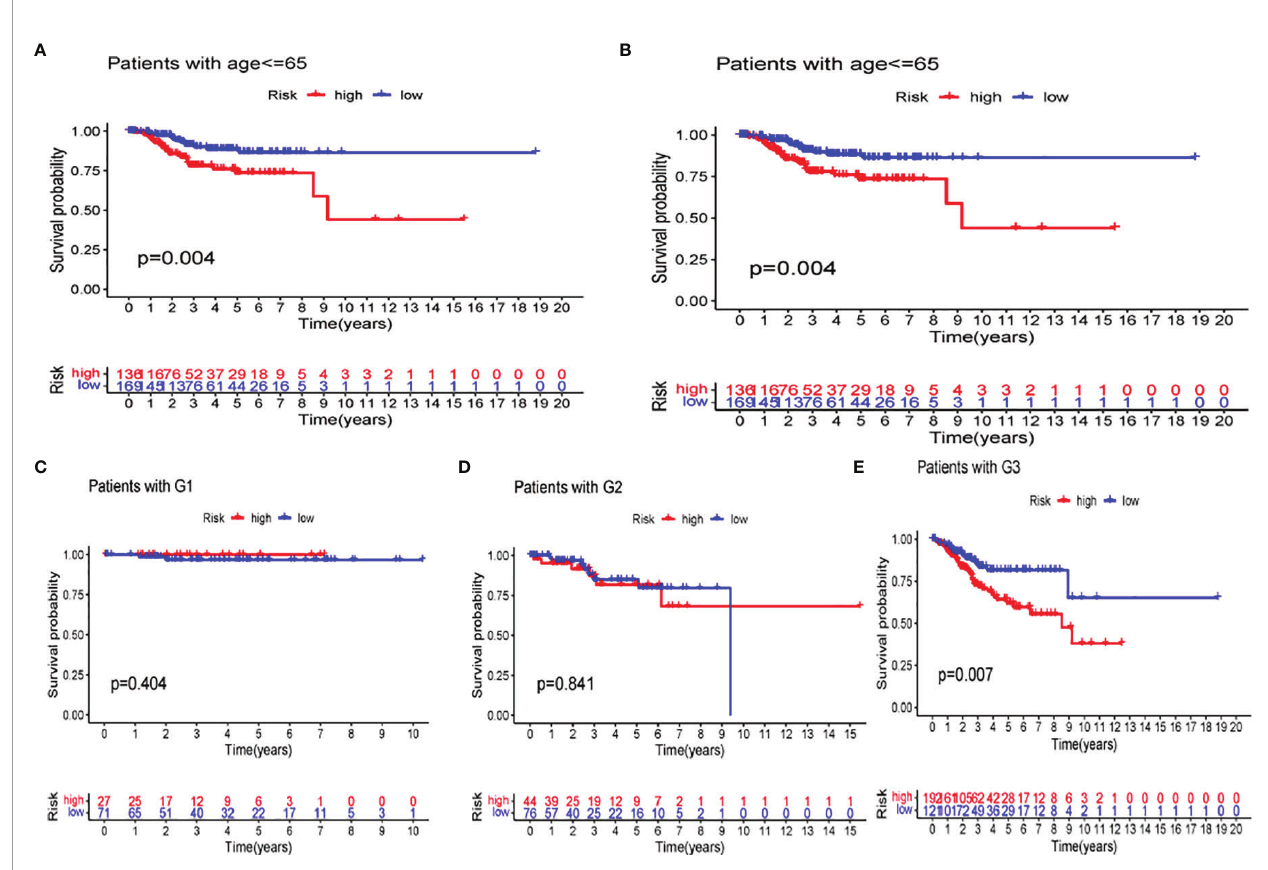
FIGURE 11 | Kaplan – Meier curves of overall survival (OS) differences strati fi ed by age (A, B) and tumor stage (C – E) between the low- and high-risk groups in The Cancer Genome Atlas (TCGA) data